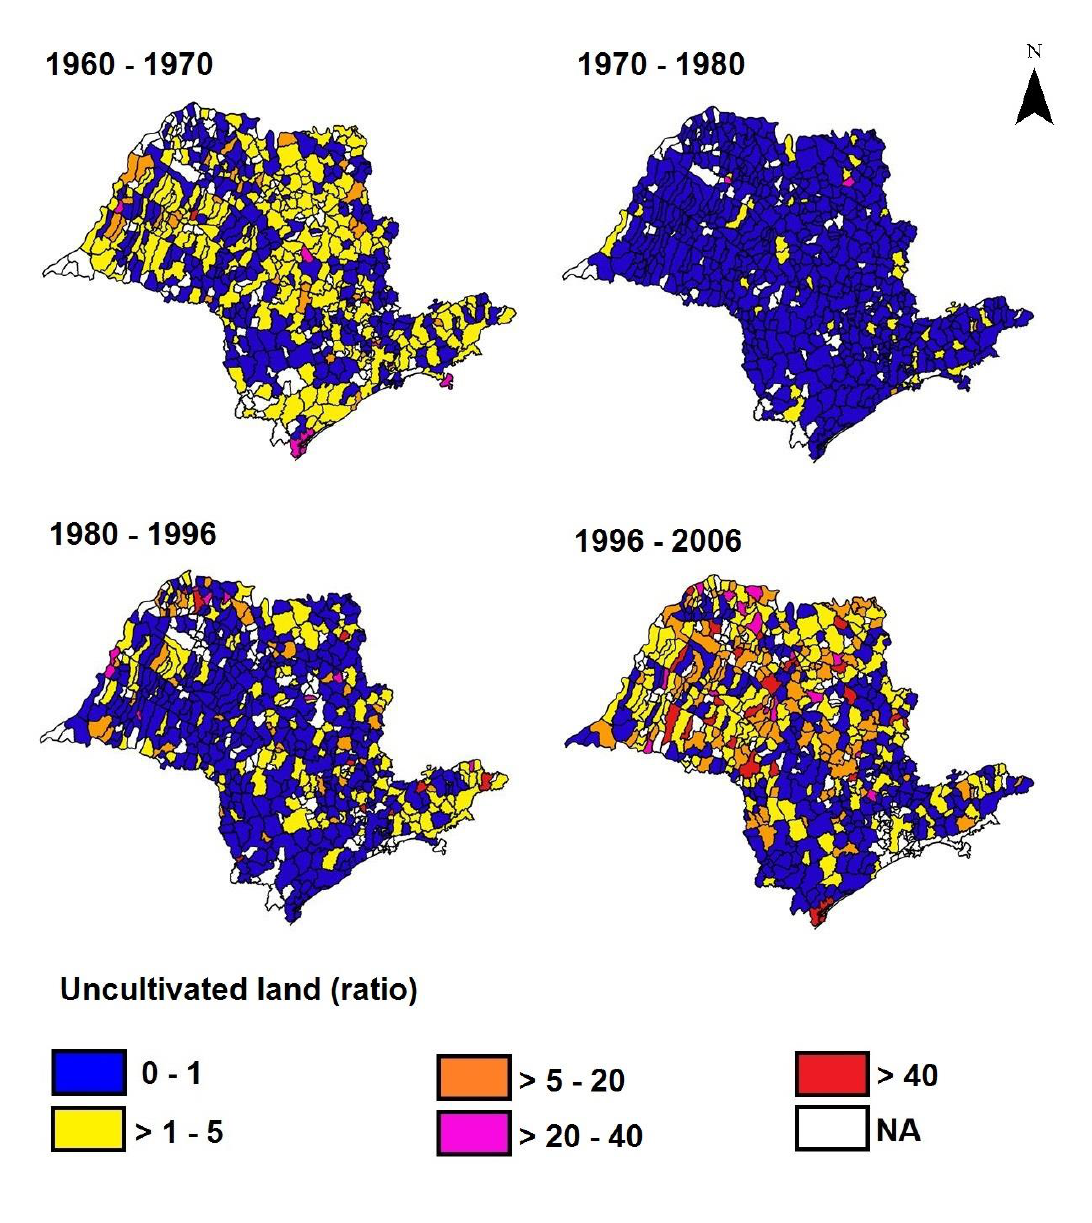
FIGURE A1.9 Uncultivated land ratio at the municipality-scale for São Paulo state calculated for the intervals 1960-1970, 1970-1980, 1980-1996 and 1996-2006. Uncultivated land ratio was calculated by dividing the uncultivated land percentage in one census by uncultivated land percentage in the previous census (e.g. values in 1970 / values in 1960). Ratio values greater than 1 (one) indicate that uncultivated land increased over the census interval and values lower than 1 (one) indicate that it decreased. Municipality boundaries are shown in black. (NA) Missing